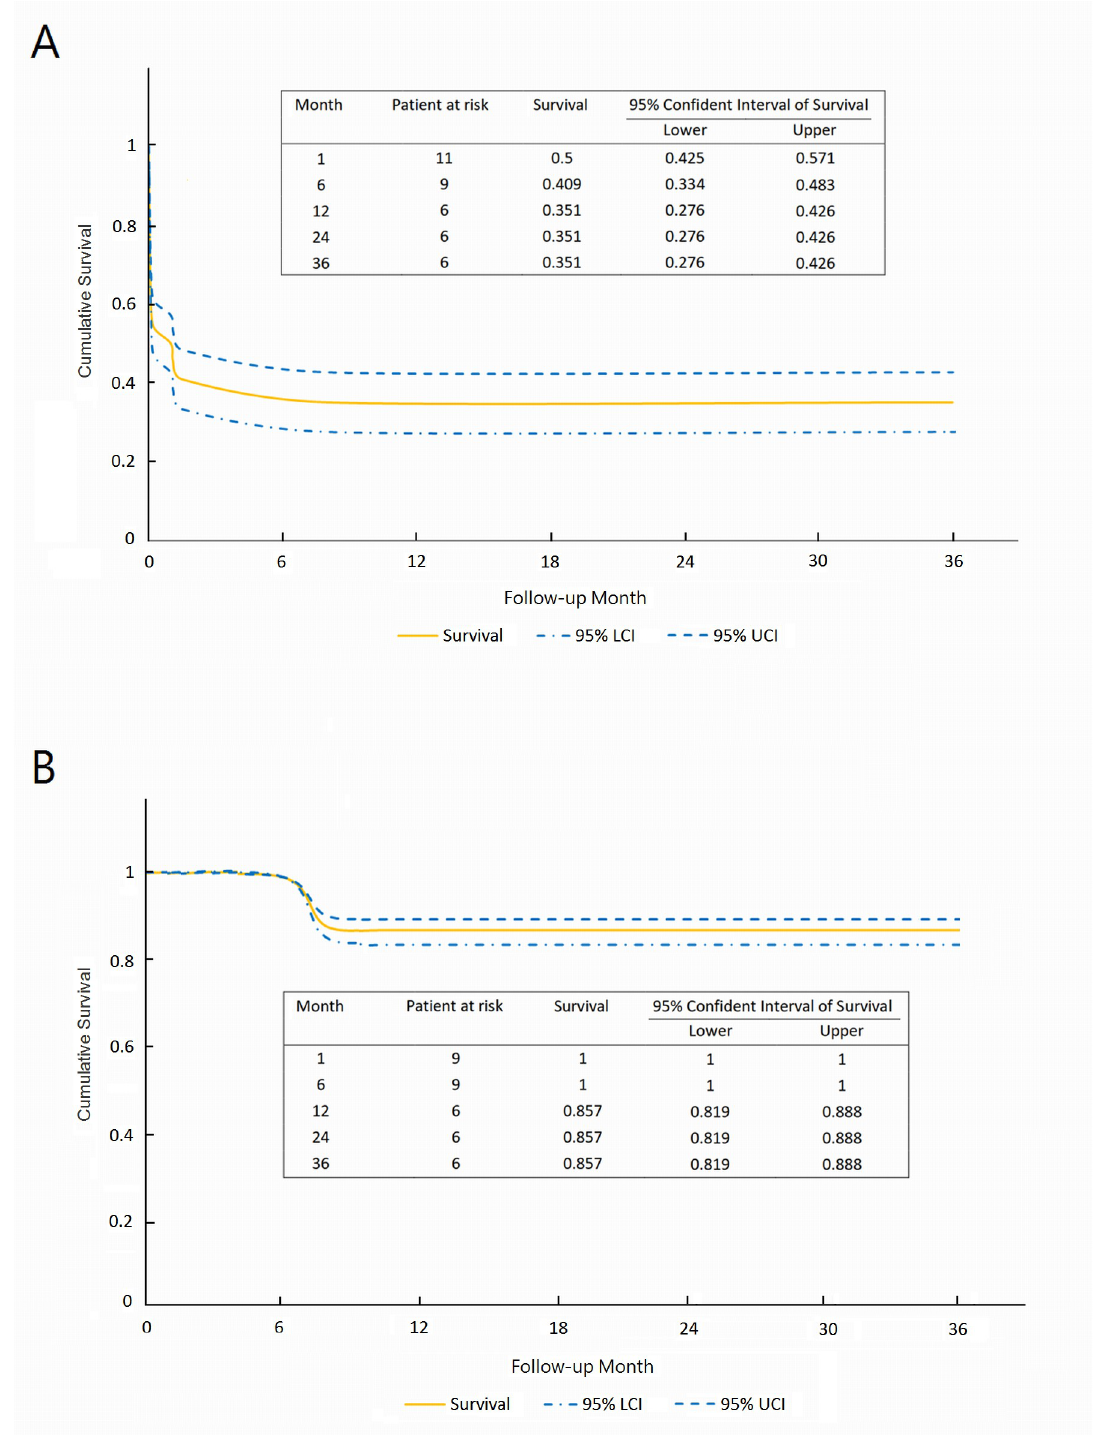
Fig 3. Three-year cumulative survival rates for 22 patients including in-hospital mortality (A) and for 9 patients who survived to discharge (B).